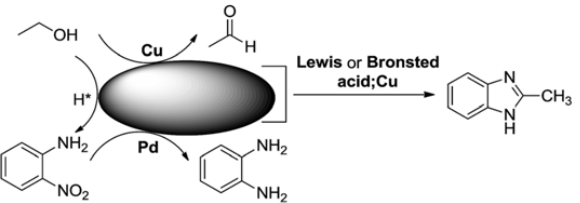
Figure 4. Synthesis of 2-methyl benzimidazole from ethanol and o -nitroaniline catalyzed by a multifunctional CuPd NPs/ γ -Al 2 O 3 . Reproduced from reference [43] with permission of The Royal Society of Chemistry.